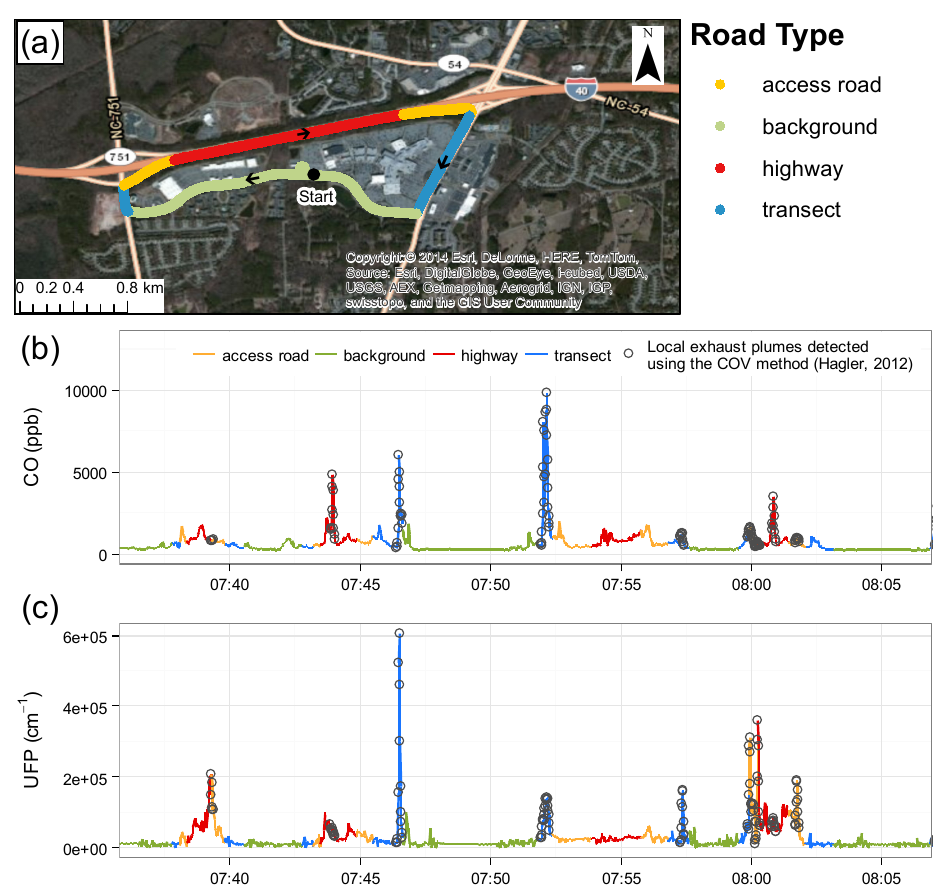
Figure 3. Map of route B used to compare methods detecting local exhaust plumes and smoothing techniques (a) , measured CO concentra- tions (b) , and measured UFP concentrations (cm − 3 ) during a portion of a sampling run (c) . Circles represent local exhaust plumes identified using the COV method (Hagler et al.,